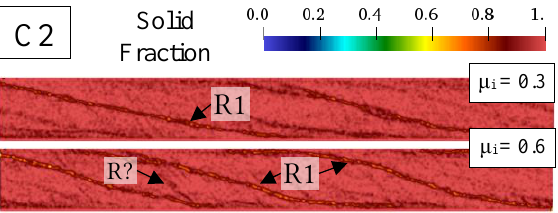
Fig. 7. Solid fraction at slip distance C2 for two different inter- particle frictions ( 𝜇 𝑖 = 0.3 & 0.6) , L 20 , letter from Fig. 5. The two Riedel bands described as low-angle (R1) and high angle (R2) do not have the same growing